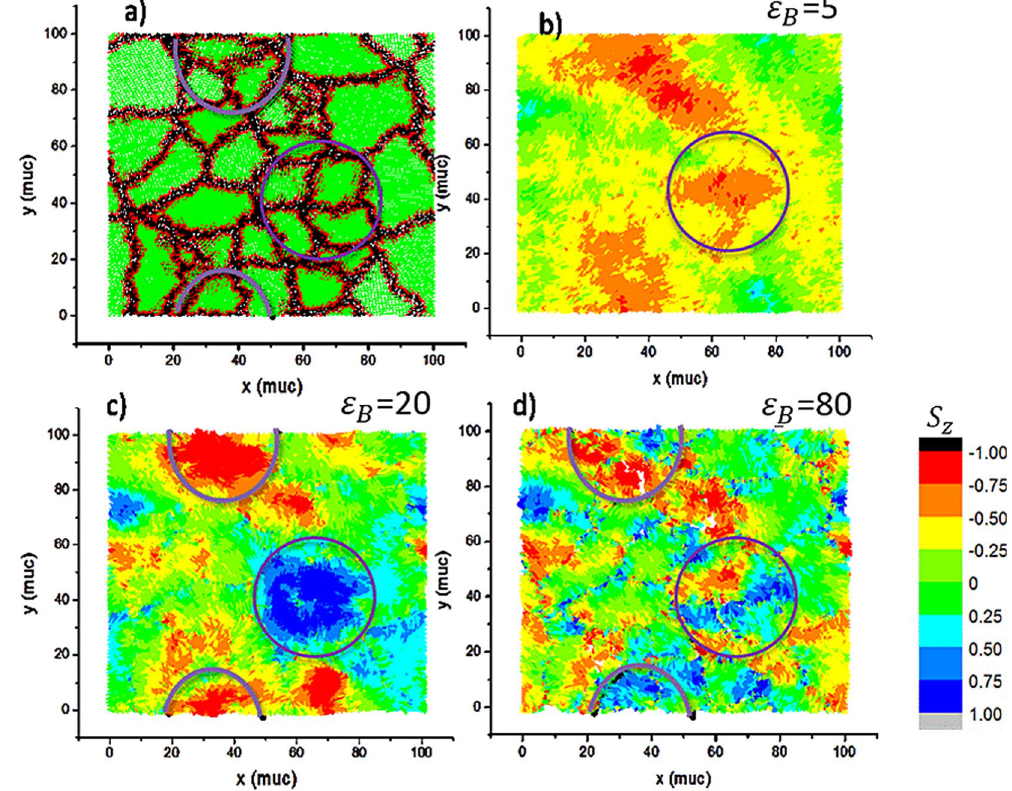
Figure 6. ( a ) Structural distribution of grains for a particular sample, ( b ), ( c ) and ( d ) representations of S magnetic components for final states at 2 K in cooling process for ε = 5 Circle evidence a correspondence between grain boundaries and domains at different values of ε